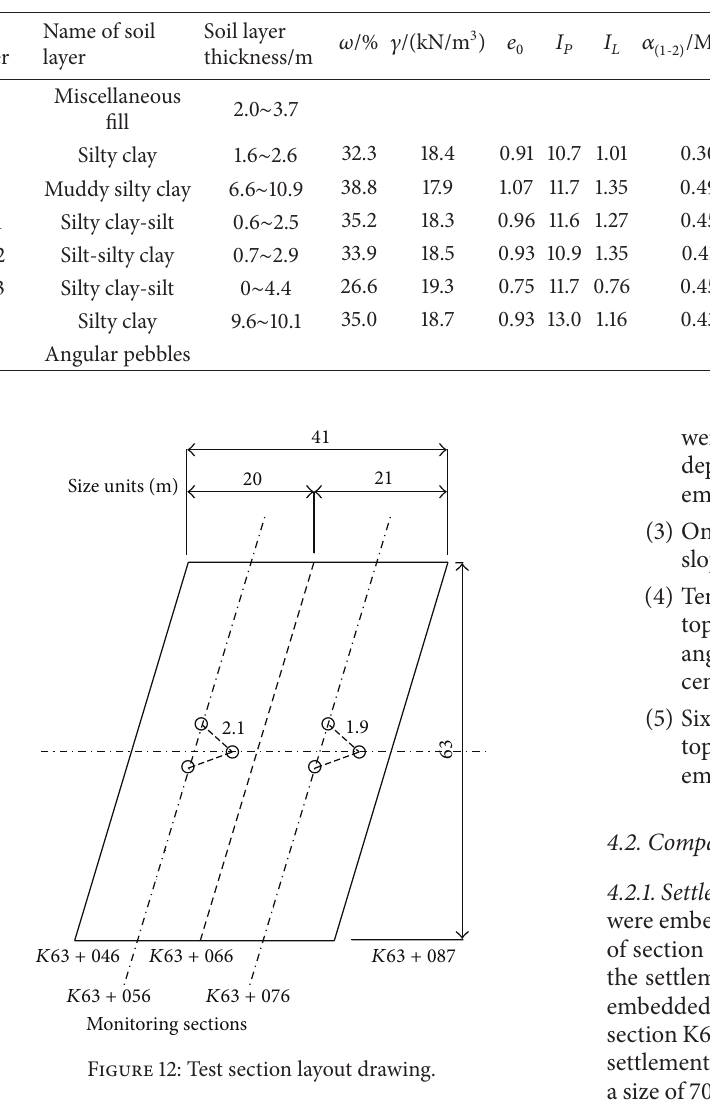
Table 2: Physical and mechanical parameters of soils.